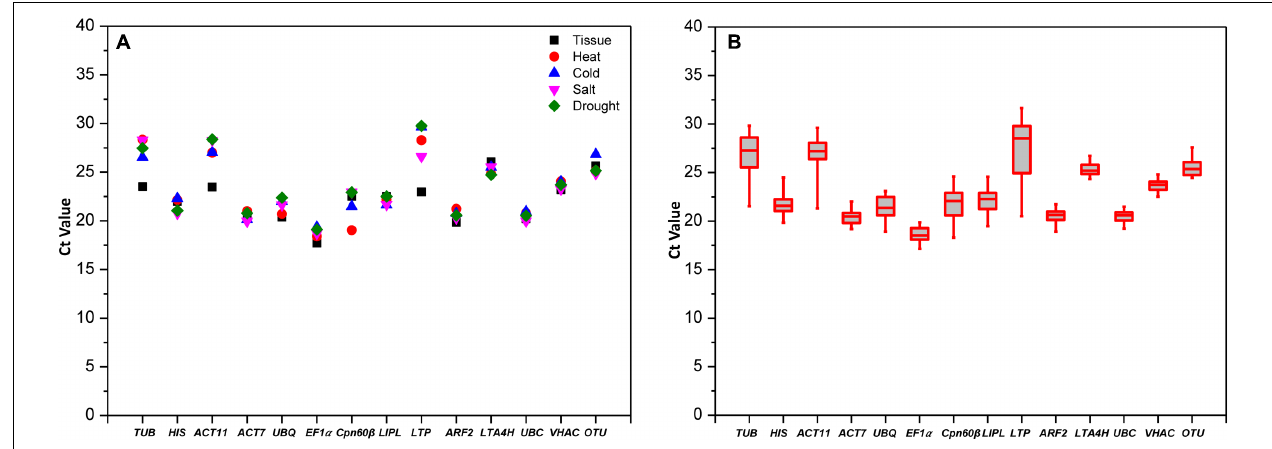
FIGURE 1 | qRT-PCR C t values of the 14 candidate RGs in all experimental samples. (A) Mean values in different treatments. (B) Box-whisker plot showing the C t variation among 30 test samples. A line across the box depicts the median. In each box, the upper and lower edges indicate the 25th and 75th percentiles.